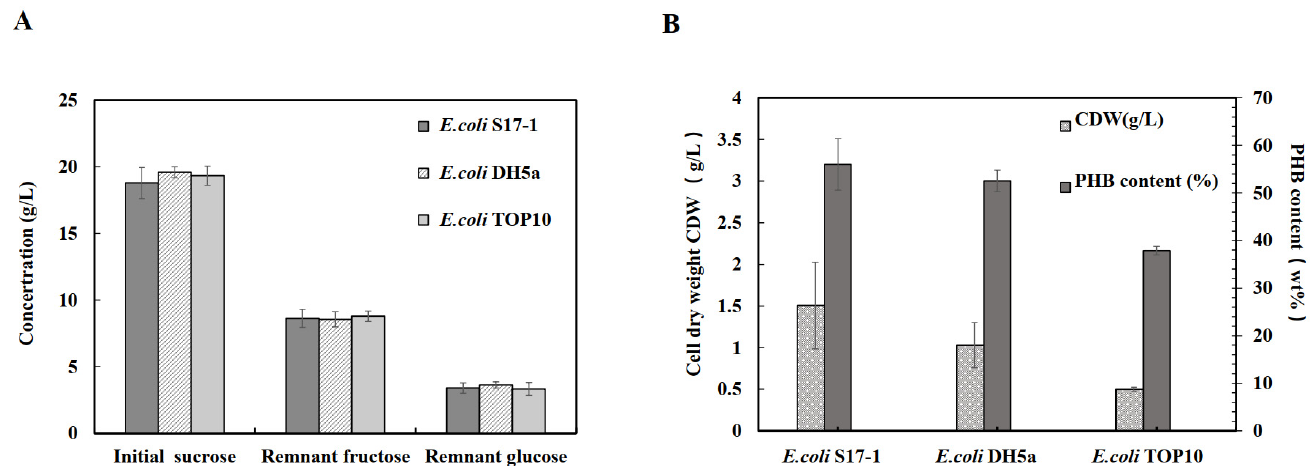
Figure 2. Sugar concentrations, cell dry weight (CDW), and PHB content in the culture flasks of the recombinant E. coli strains. ( A ) Concentrations of sucrose, glucose, and fructose were measured to investigate the utilization of sucrose; ( B ) CDW and PHB contents in the three recombinant strains of E. coli using sucrose as a substrate after 48 h cultivation.